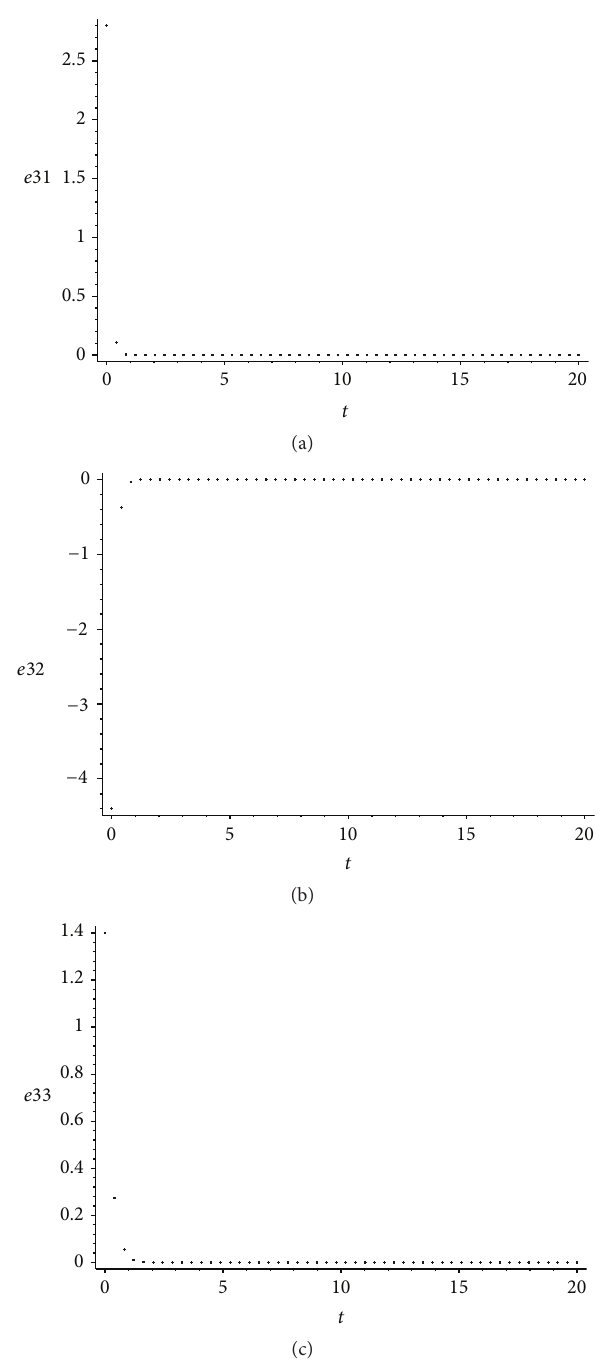
Figure5:Networksynchronizationerrorsbetweennode2andnode